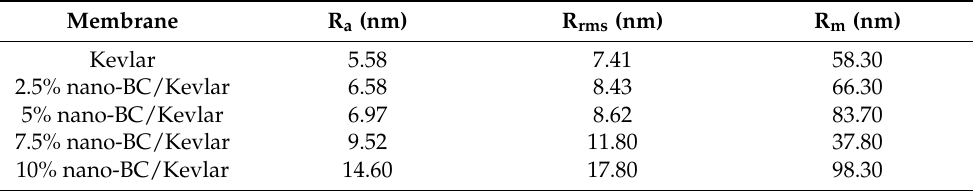
Table 2. AFM parameters of the pristine and modified membranes.